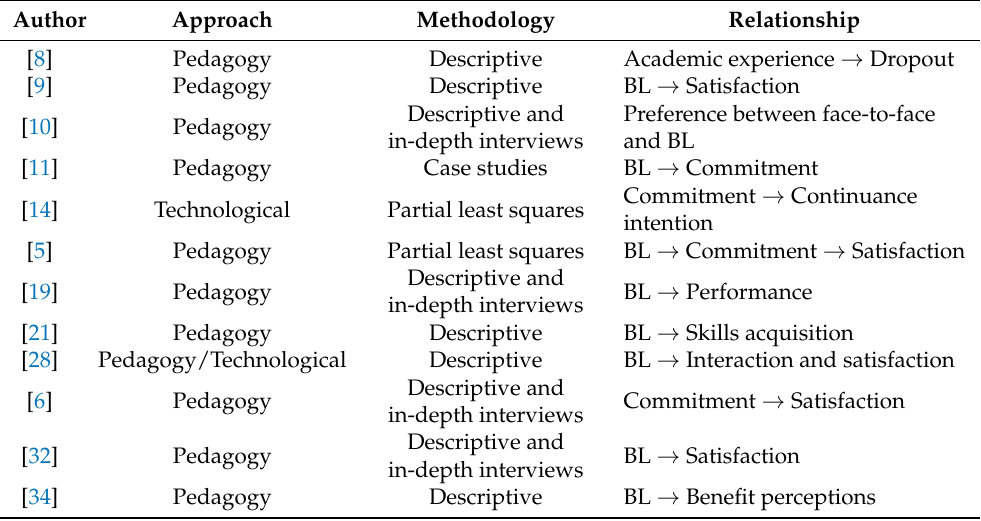
Table A1. A sample of approaches from previous studies.